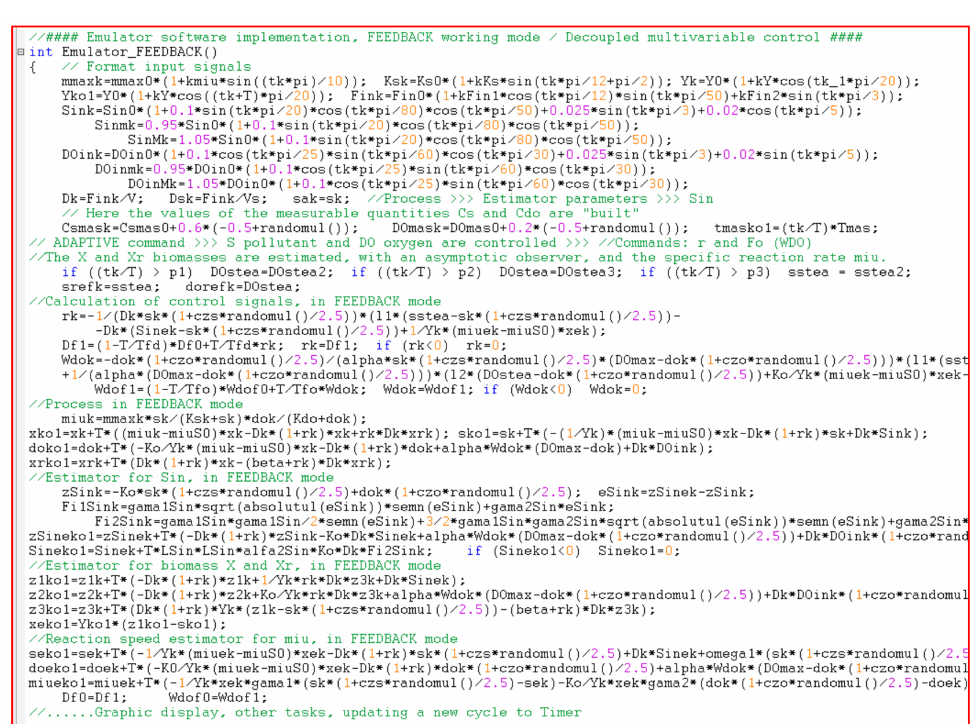
Figure 11. Closed-loop emulator of the adaptive controlled ASP—second screen, with several graphs for the visualization of the main variables’